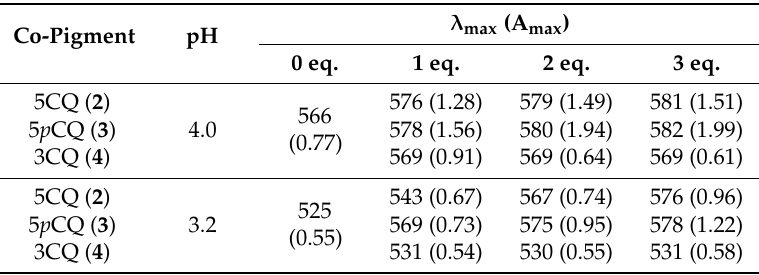
Table 1. λ vismax and absorbance of reproduced solutions. Dp3G ( 1 , 0.1 mM), Al 3+ (0.1 mM, 1 eq.) in 2 mM buffer